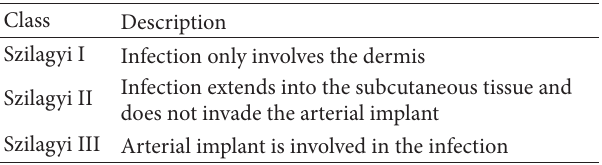
Table 1: Szilagyi classification of surgical site infections.